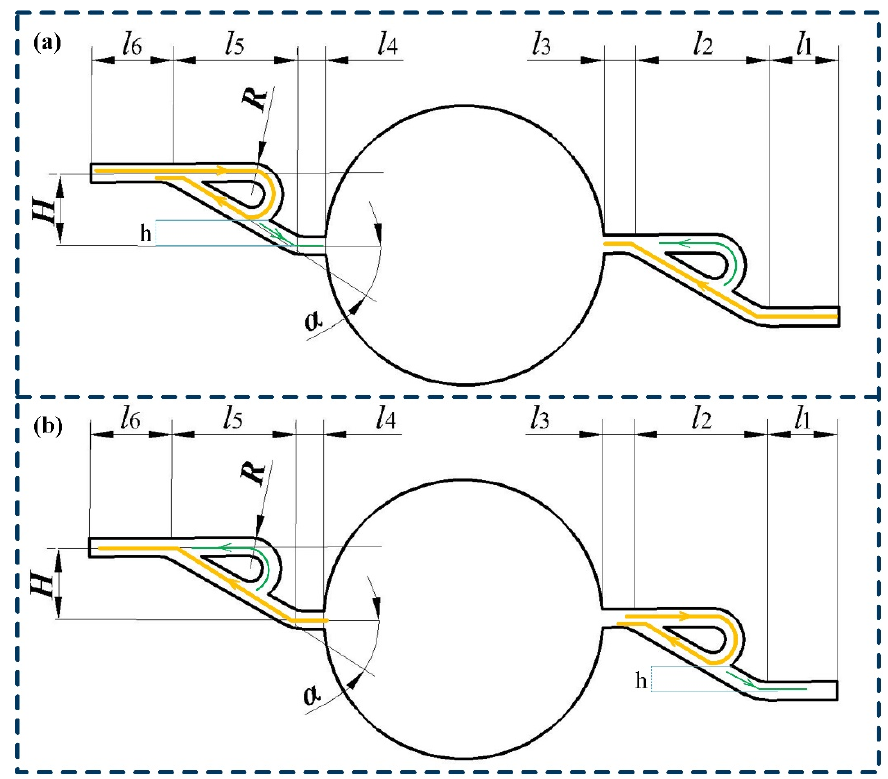
Figure 3. The structure of a Tesla valve: ( a ) liquid inflow; ( b ) liquid outflow. At the stage of liquid inflow (as shown in Figure 3a), the friction loss of each part from l 1 to l 6 includes h f , h f , 2 1